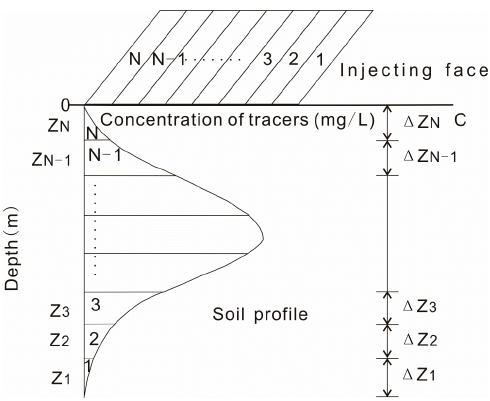
Figure 3. Model of multi ‐ regions for estimating groundwater recharge in this study.